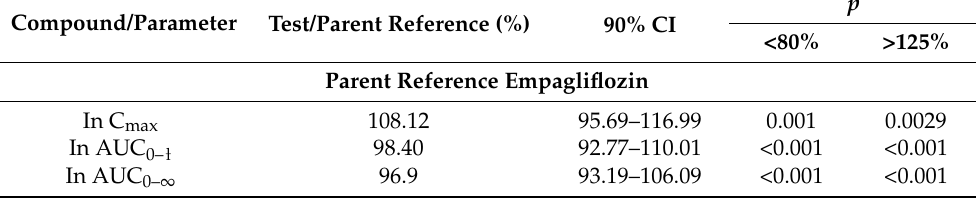
Table 2. Correlation of 90 percent CIs of Ln-transformed variables for the parent reference